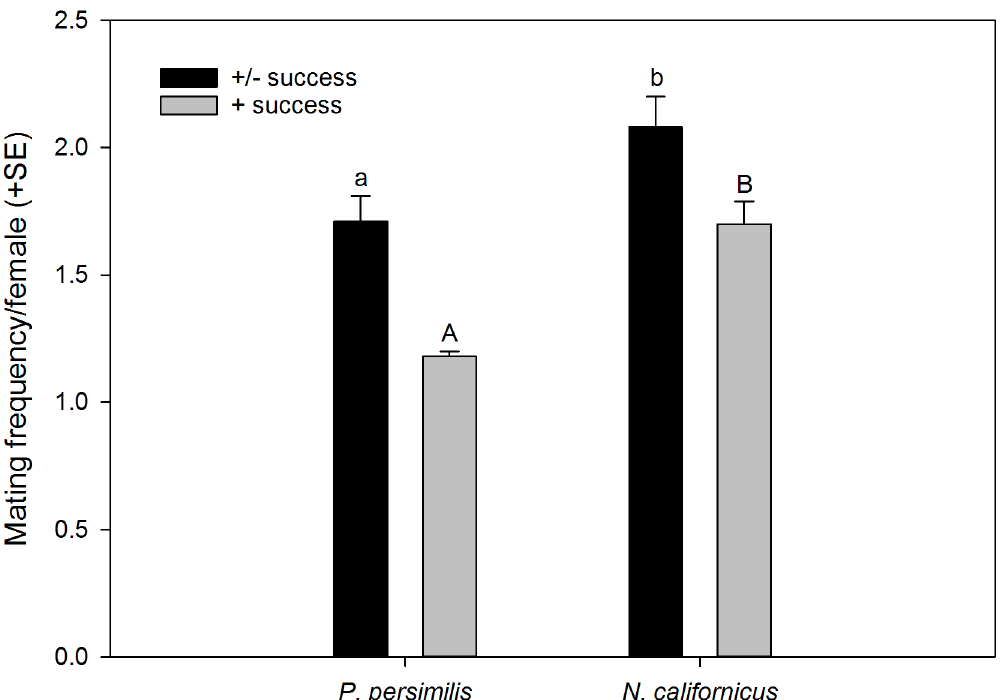
Fig 1. Mating frequency. Number of matings of females of P . persimilis (N = 30) and N . californicus (N = 23), including all male mates (independent of their paternity success; +/- success) and including only those male mates with paternity success (i.e. those siring at least one offspring of a given female; + success). Different letters on top of bars indicate significant differences between species within +/- success and + success (GLMs; P < 0.05).